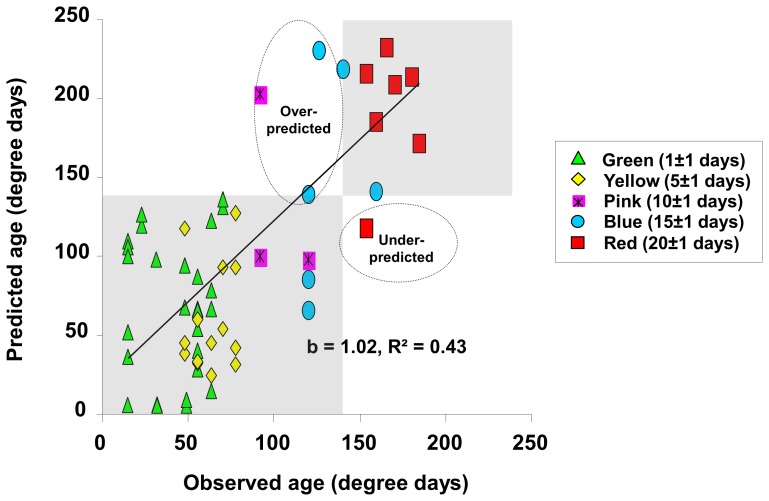
Correlation between the age of released Anopheles gambiae mosquitoes and that predicted based on the transcription profiles of two genes.Fluorescently labeled, released and re-captured (MRR) mosquitoes (n = 63) of known age were used in this experiment. The data points outside of the shaded areas in the figure represent mosquitoes whose age was over-predicted (3) or under-predicted (1) by the molecular markers. The b represented the slope of regression line. The number of each age group mosquitoes was used to age prediction: Green = 32, Yellow = 15, Pink = 3, Blue = 6 and Red = 7.